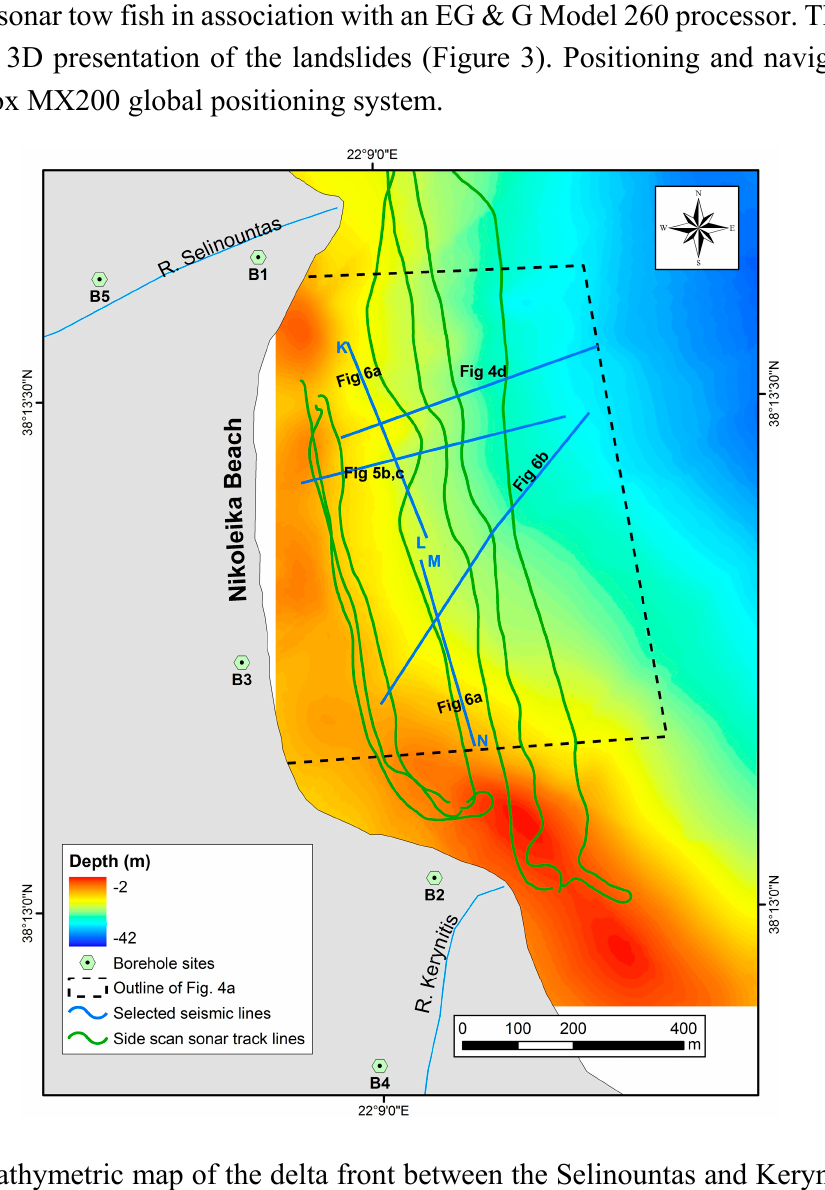
Figure 3. Bathymetric map of the delta front between the Selinountas and Kerynitis rivers, affected by the landslide, showing side scan sonar tracklines, selected 3.5 kHz seismic profiler tracklines, and the borehole